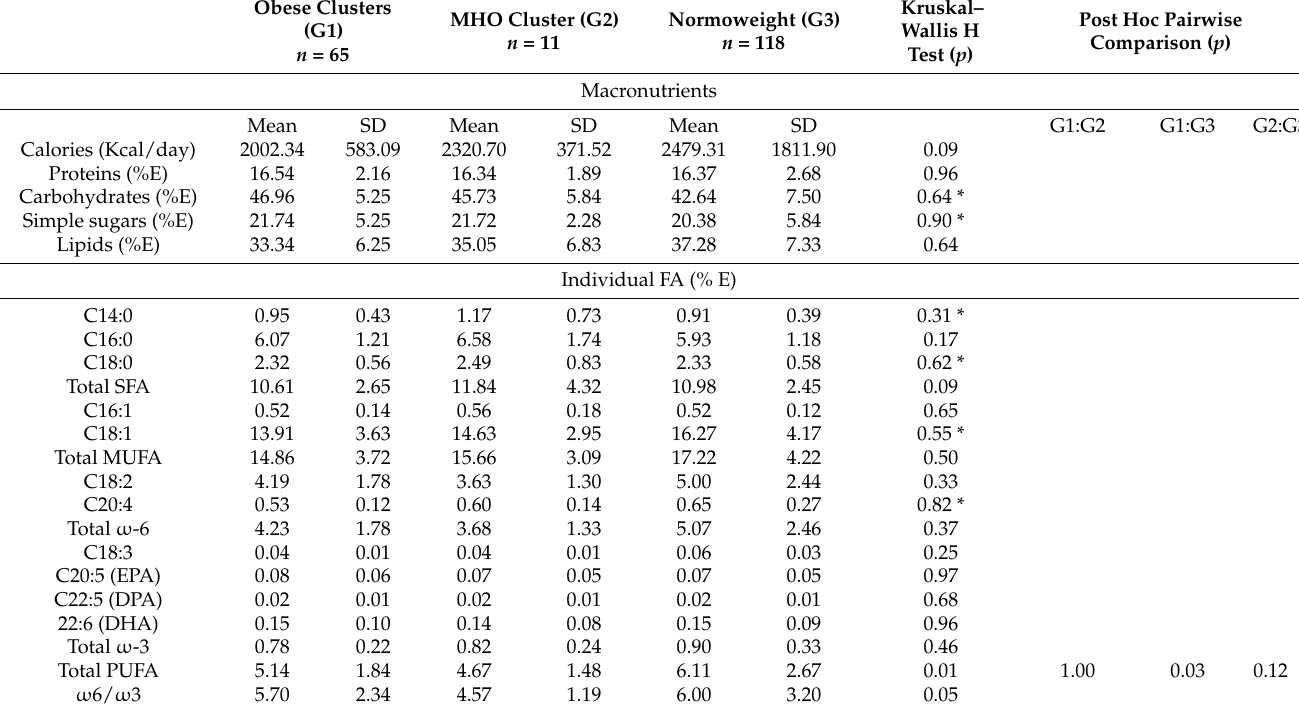
Table 3. Dietary daily intake expressed as % of energy (%E).